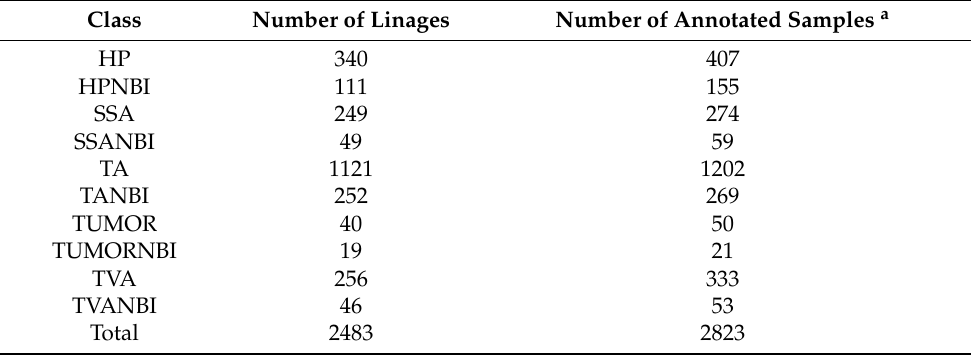
Table 1. List of categories included in our dataset and their annotated